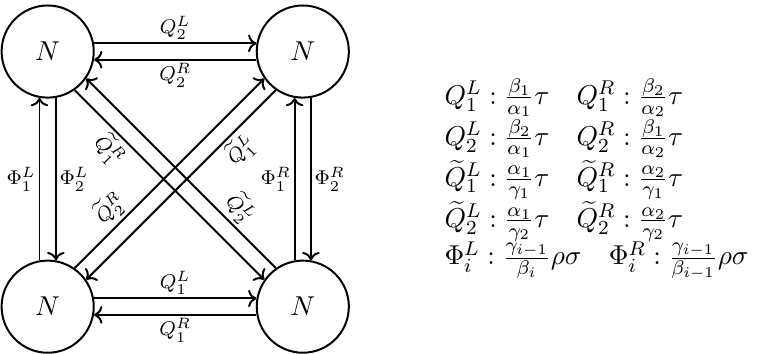
Figure 8. Quiver diagram of the k = 2 theory associated to a torus with ‘ = 2 minimal